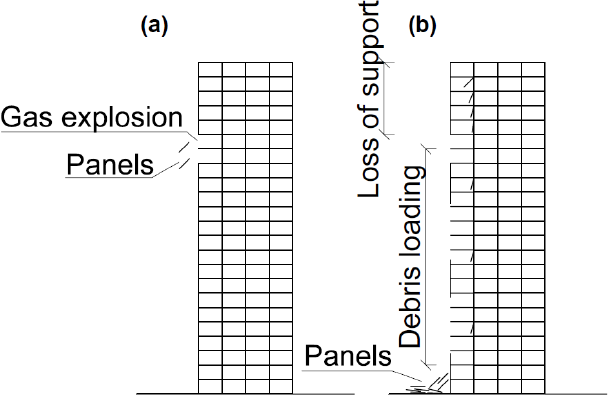
Figure 9. Problems with structural integrity in LPS buildings: ( a ) immediate local damage followed by ( b ) progressive collapse (based on the information provided in [64]).